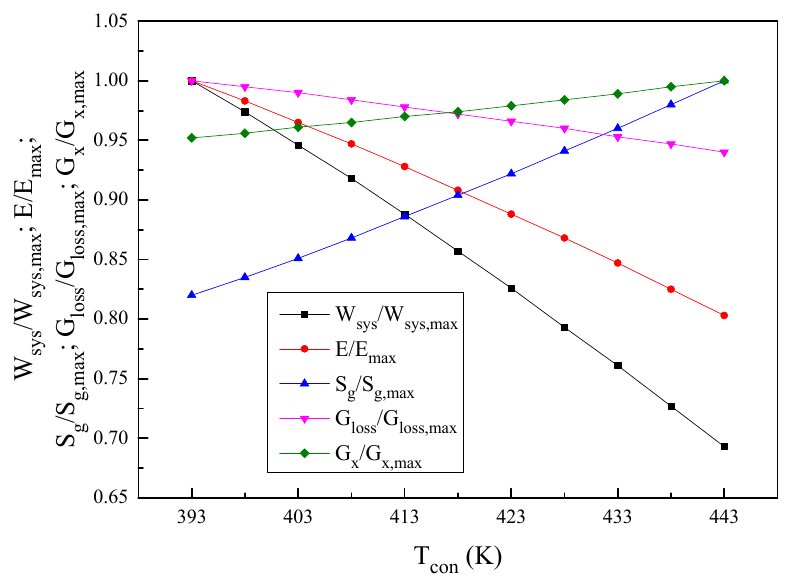
Figure 5. Effects of HT loop condensation temperature for hexane/toluene. Figure 5. E ff ects of HT loop condensation temperature for hexane /